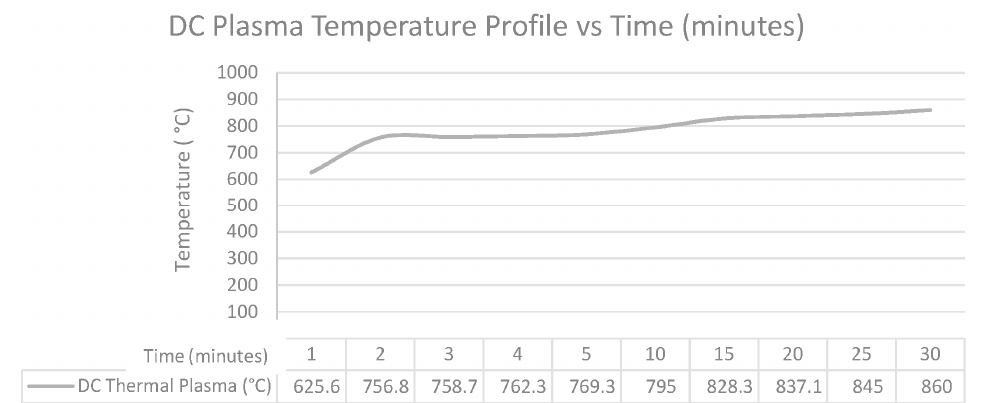
Figure 12. Temperature profile of DC thermal plasma.